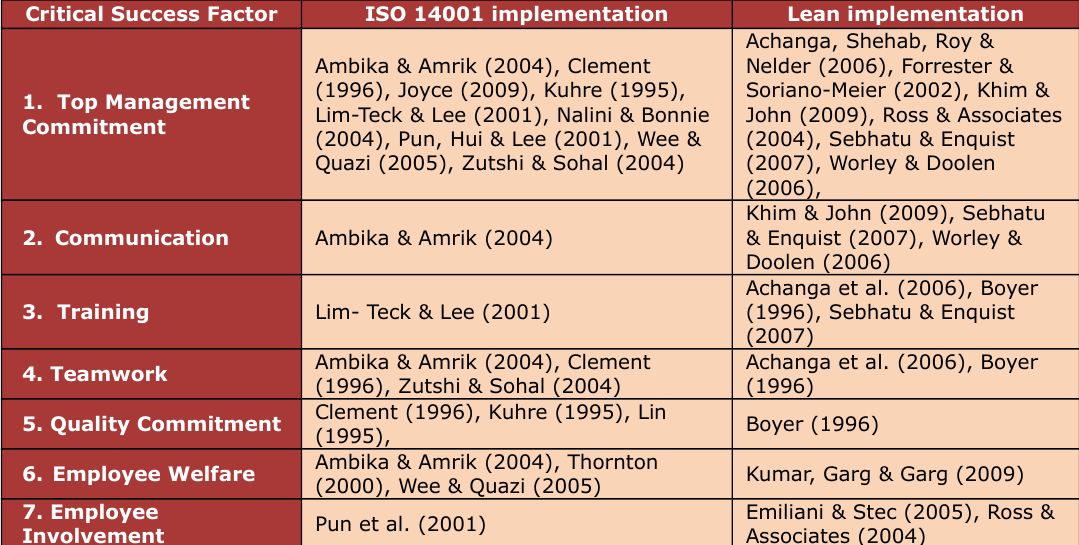
Critical Success Factor ISO 14001 implementation Lean implementation